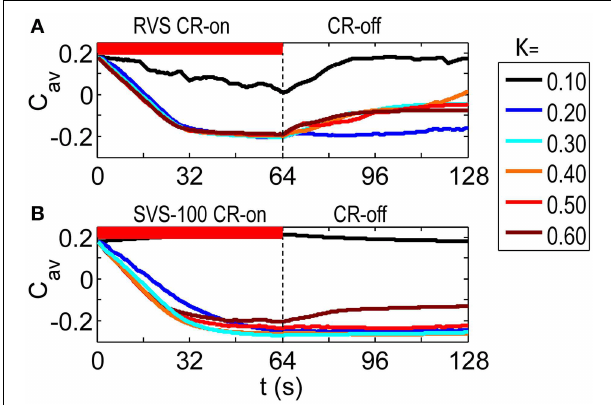
FIGURE 2 | Dynamics of the average synaptic weight, C av , for different stimulation intensities, K . (A) Results of the RVS CR stimulation. (B) Results of the SVS-100 CR stimulation. The initial network is the same for all simulations. The sequence order used for each CR method is constant for all K -values. The CR-on period, represented by the red horizontal bar, starts at t = 0 s and is switched off at t = 64 s (dashed vertical line). During the subsequent 64s CR-off period, no stimulation is delivered, and C av evolves spontaneously. c max = 1 for all